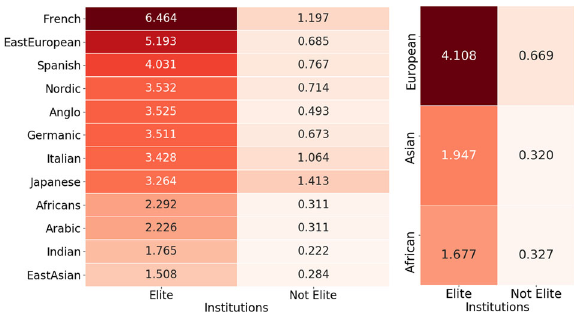
Fig. 5 The power ratio by identity. Elite circles is a strong indicator of recognition. The power ratio is the likelihood of being part of the elite community, divided by the average likelihood. It is a measure of